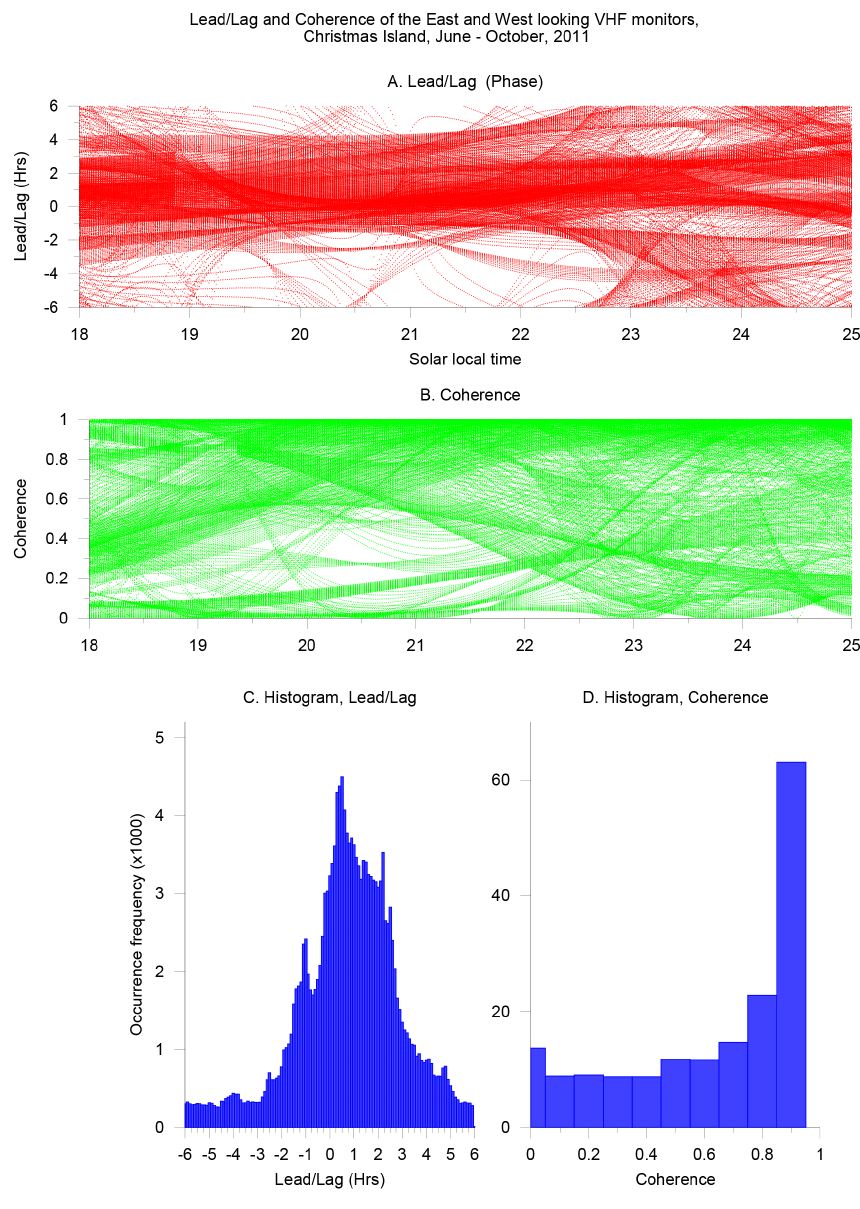
Fig. 5. Same as Fig. 3 but for peak scintillation season in